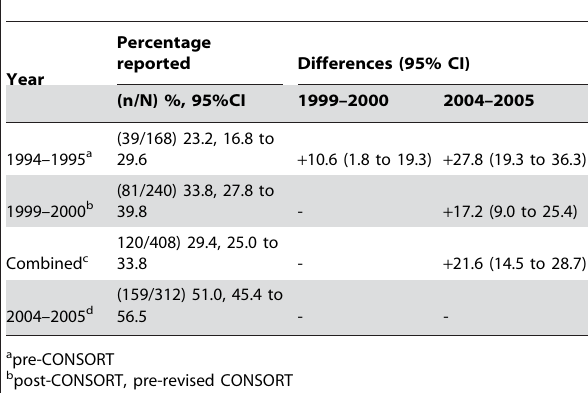
Table 4. Percentage of CONSORT items reported and between time-period